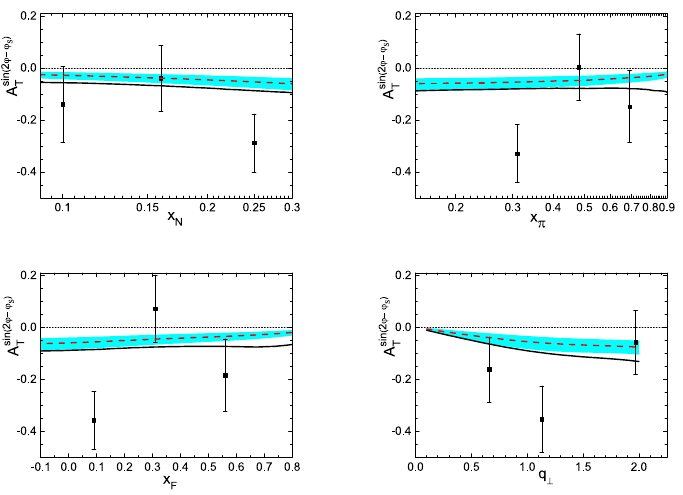
Figure 3. Similar to Fig. 1, but the asymmetry calculated from the Boer-Mulders function of the pion in a light-cone constituent model [12]. The dashed lines plot the central results, while the solid lines are the central results in Fig. 1 for